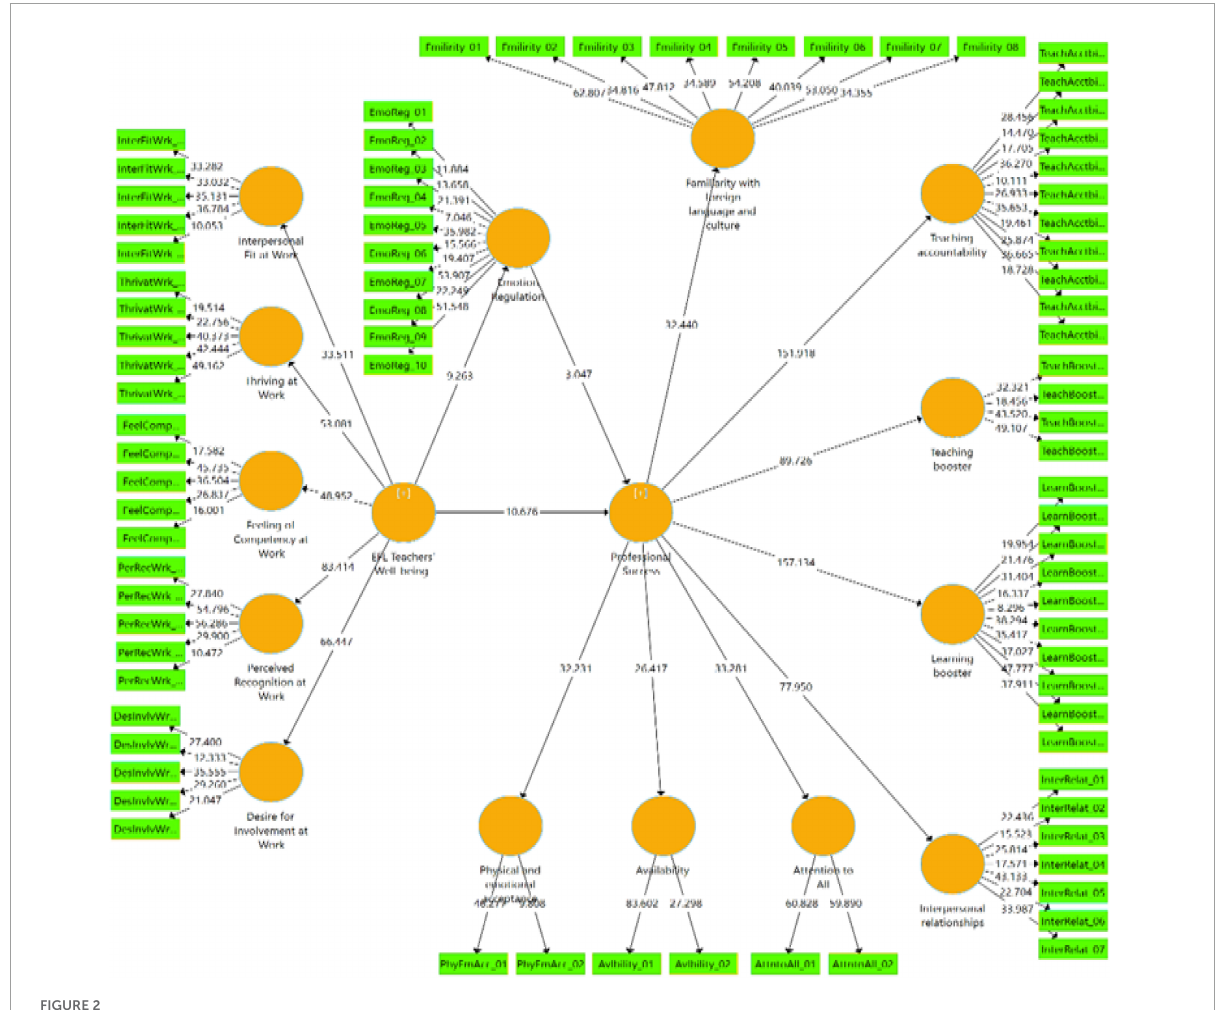
FIGURE2 The structural model with bootstrapping